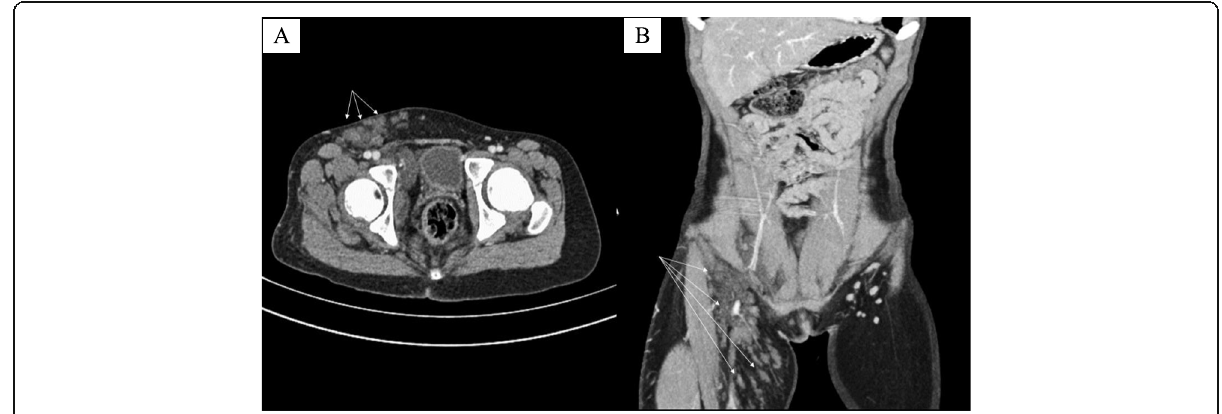
Fig. 5 Axial ( a ) and coronal ( b ) enhanced CT of abdomen and pelvis in the arterial phase demonstrate multiple enhancing subcutaneous lesions (small arrows) extending from retroperitoneum to visualized upper thigh suggestive of capillary